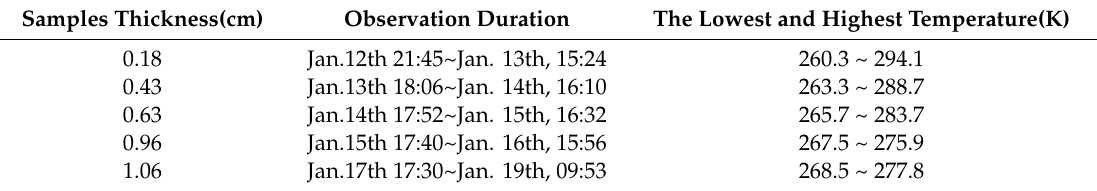
Table 2. The observed lowest and highest temperature of five soil samples.